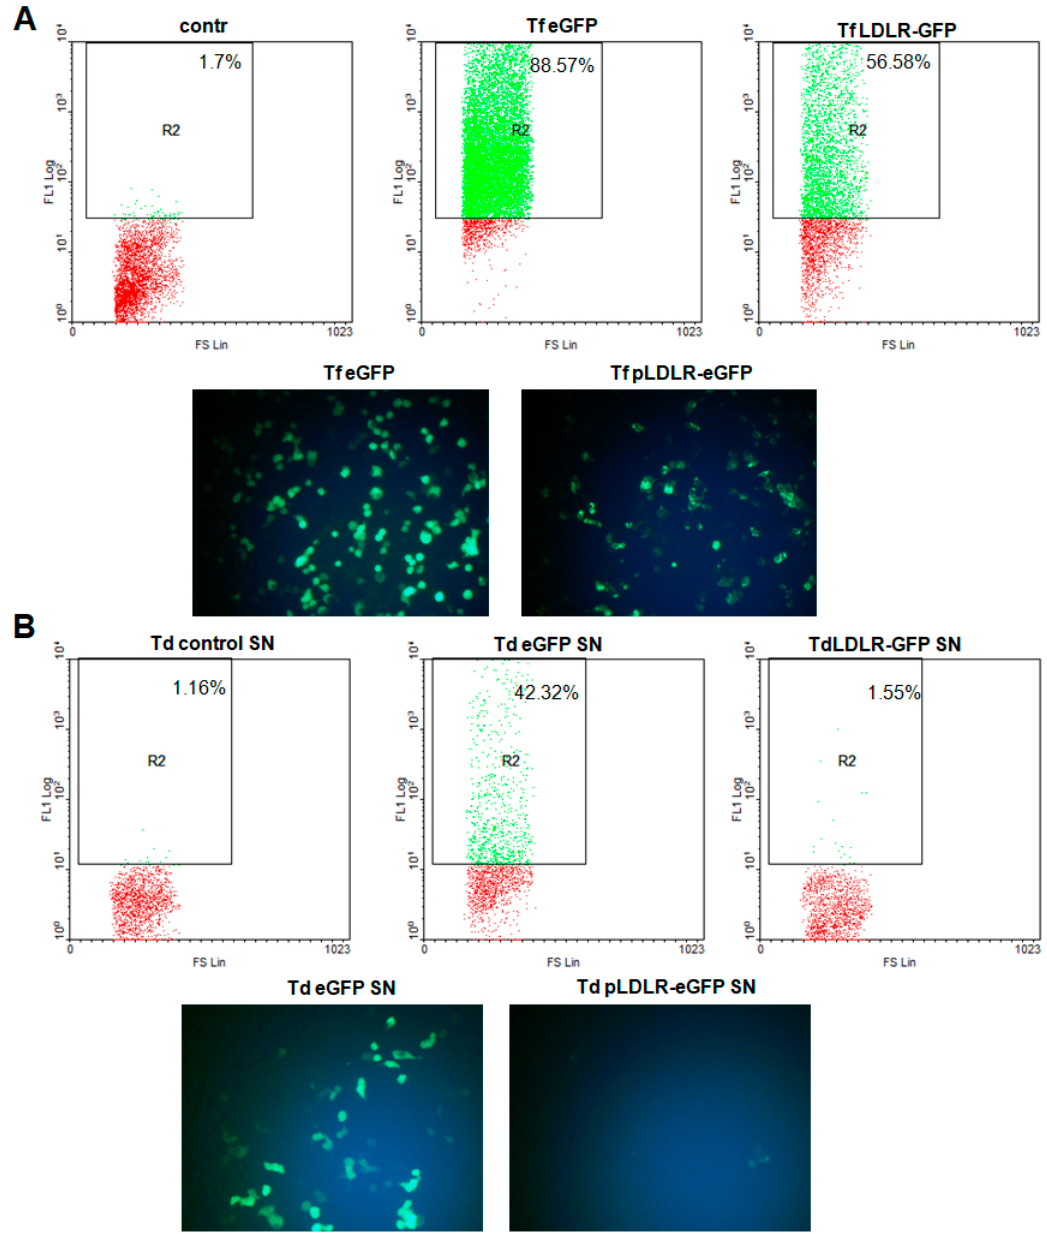
Figure 1. Transfection and transduction of 293T cells using LDLReGFP or eGFP. After transfection of